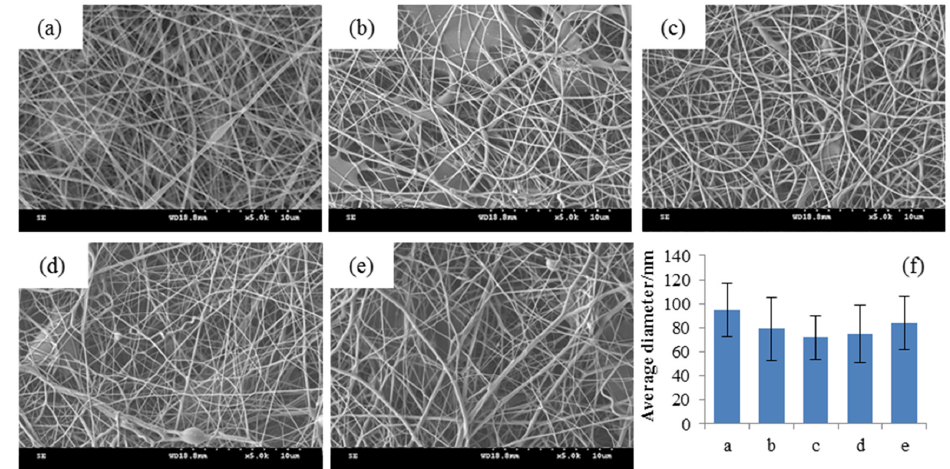
Figure 5. SEM images (5000×) of PVA/zinc citrate nanofiber mats containing ( a ) 0 wt %; ( b ) 0.5 wt %; ( c ) 1 wt %; ( d ) 3 wt %; and ( e ) 5 wt % zinc citrate; ( f ) is the diameter distribution of the nanofibers with the corresponding content of zinc citrate.